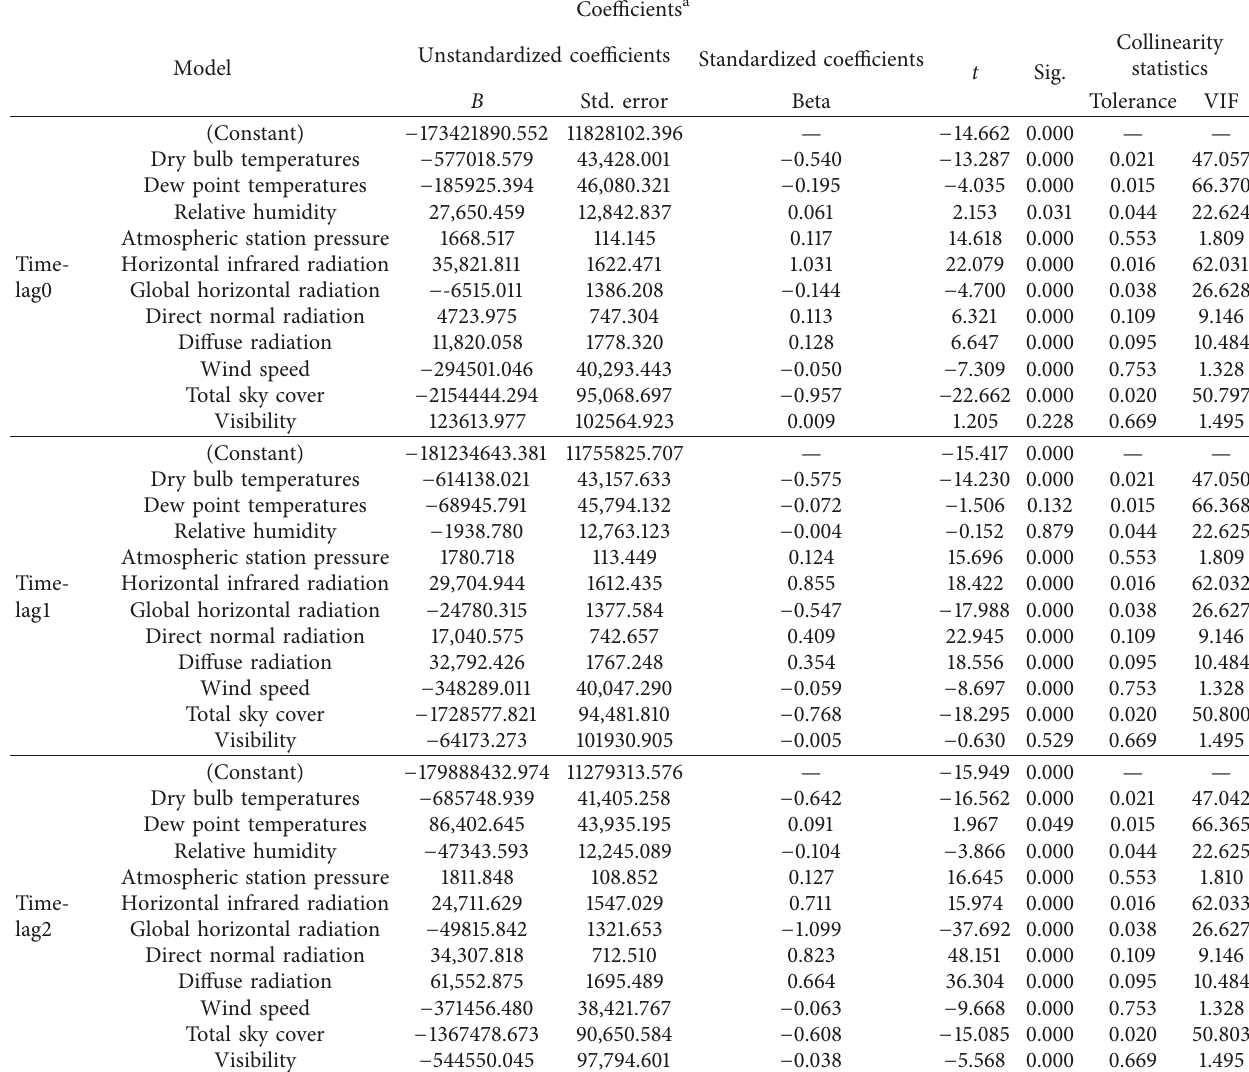
Table 5: Regression coefficients for a DOE small office building depending on time-lag.